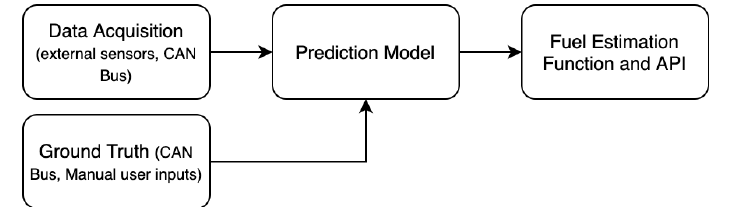
Figure 1. Fuel estimation workflow